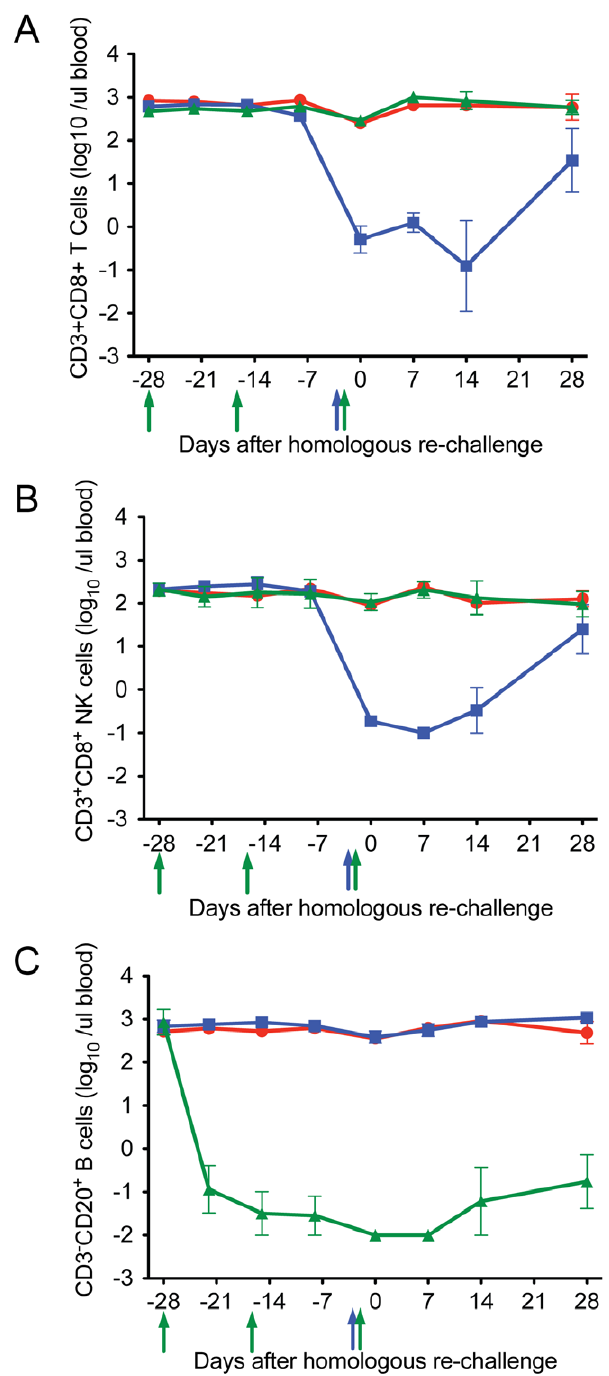
Figure 2. The effect of anti-CD20 and anti-CD8 a infusion on CD20 + B cells, CD3 + CD8a + T cells and CD3 2 CD8a + NK cells in blood of animals at the time of influenza virus re-challenge. a) CD20 + B cells in blood, b) CD3 + CD8a + T cells and, c) CD3 2 CD8a + NK cells. Green symbols and lines denote the anti-CD20 monkeys (n=3), blue symbols and lines denote the anti-CD8 a -treated monkeys (n=3) and red symbols and lines denote un-treated monkeys (n=3). Day 0 indicates the day of influenza re-challenge. Anti-CD20 was infused 28, 14, and 3 days prior to the day of influenza re-challenge, anti-CD8 was infused 3 days prior to virus inoculation. Arrows indicate the timing of the antibody infusions; blue arrow indicates anti-CD8a infusion and green arrows indicate anti-CD20 infusions.